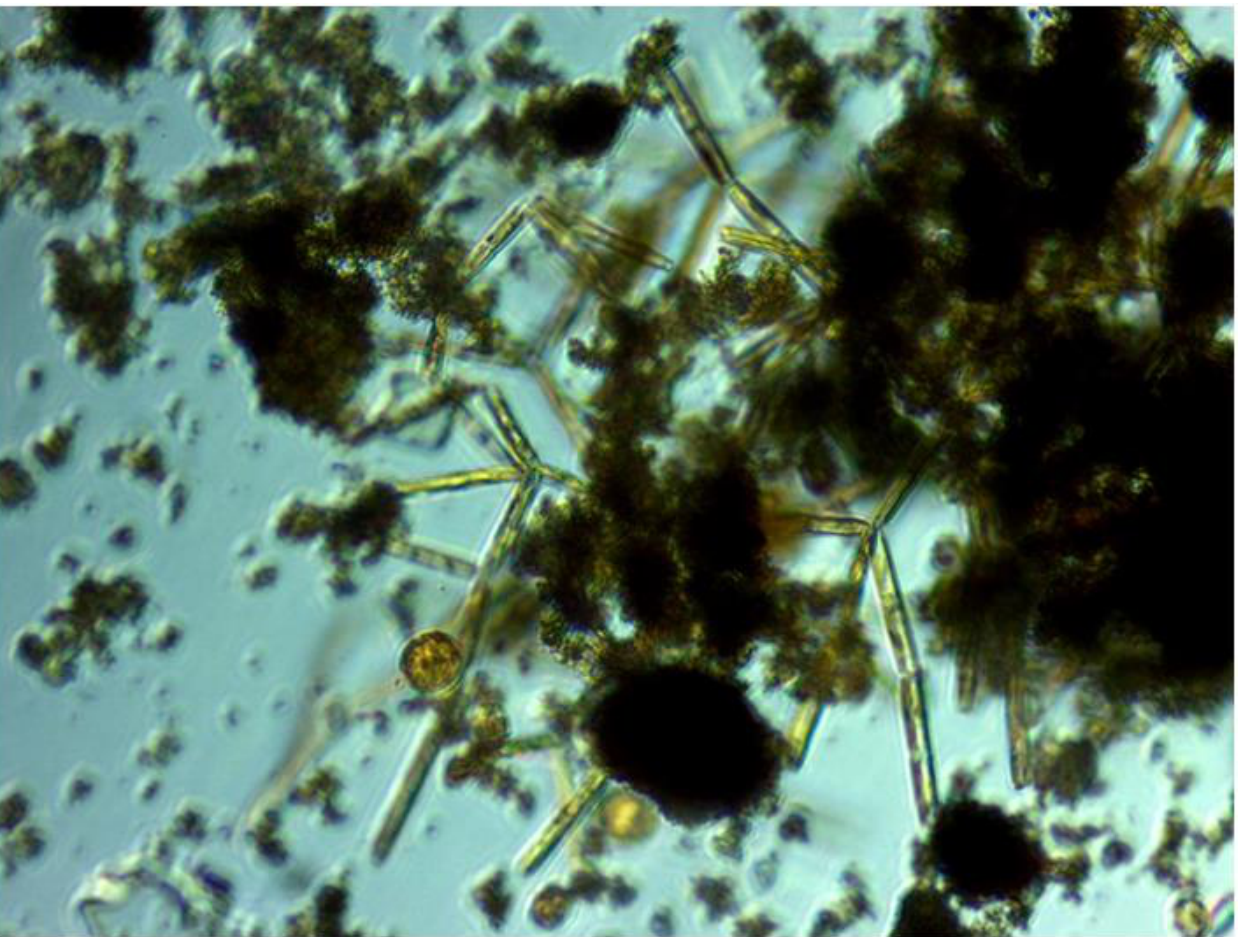
Figure 8. Colonies of the ice diatom Nitzschia frigida growing in lab cultures from sediment samples collected in Rijpfjorden in January.